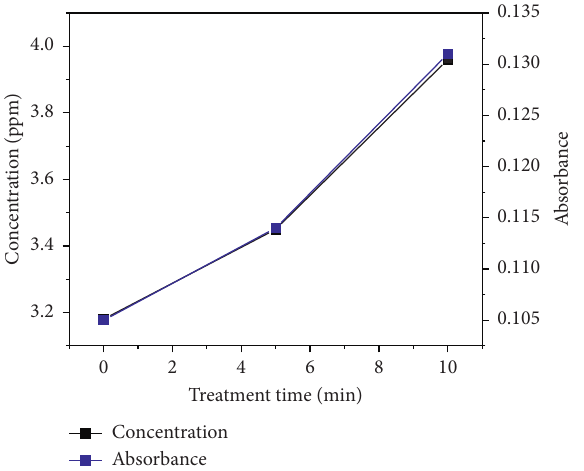
Figure 10: Absorbance and concentration of ferrous ions with treatment time (5kV, 19.56kHz, and 5 L/min).